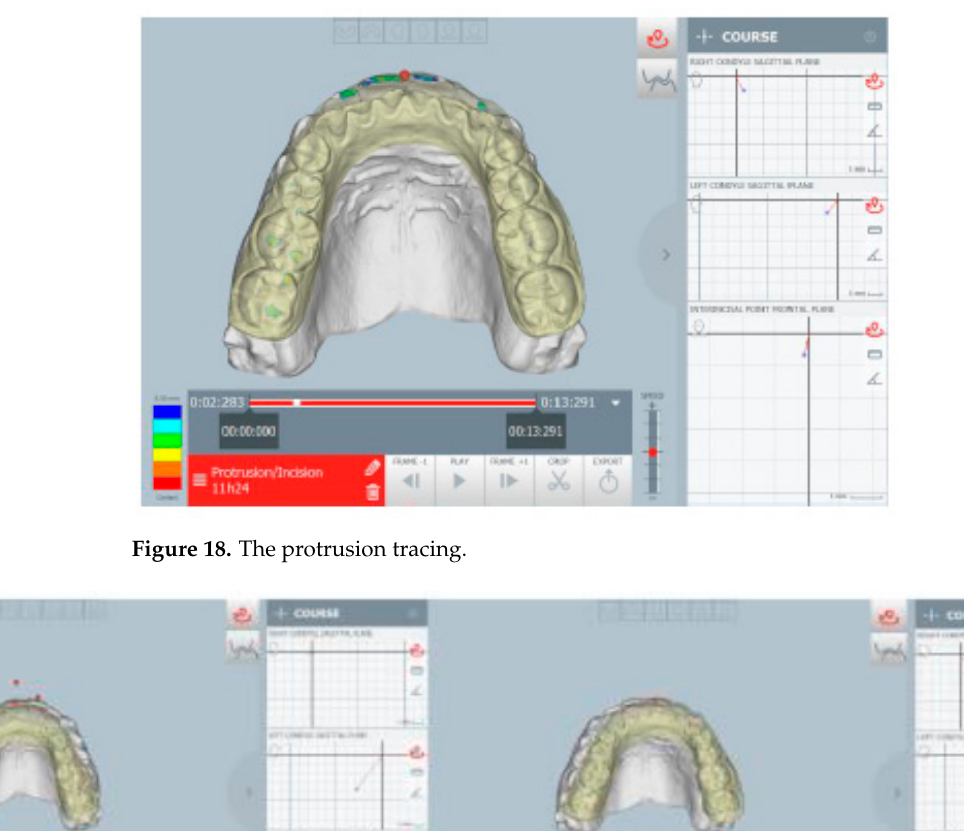
Figure 17. Mandibular kinematic during opening. There was a normal opening amplitude, with deflection to the left side. There were some slight deviations to the right and left, not always present during the opening movements. The right condylar path showed hypermobility in maximum opening.